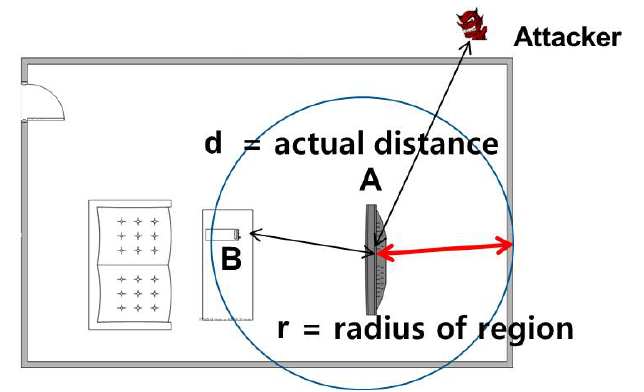
Figure 2. Attacker location and pre-defined